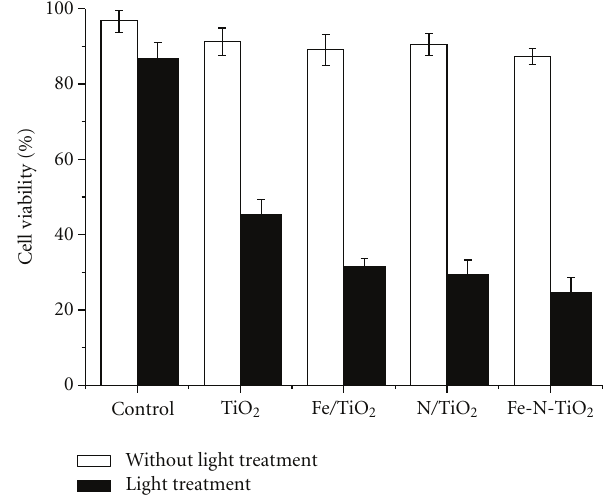
Figure 6: The e ff ect of light irradiation on cell viability at an intensity of 5.0mW/cm 2 for 30 minutes in the presence of TiO 2 or doped TiO 2 . Each data point represents mean ± SD ( n = 3). ∗ P < 0 .